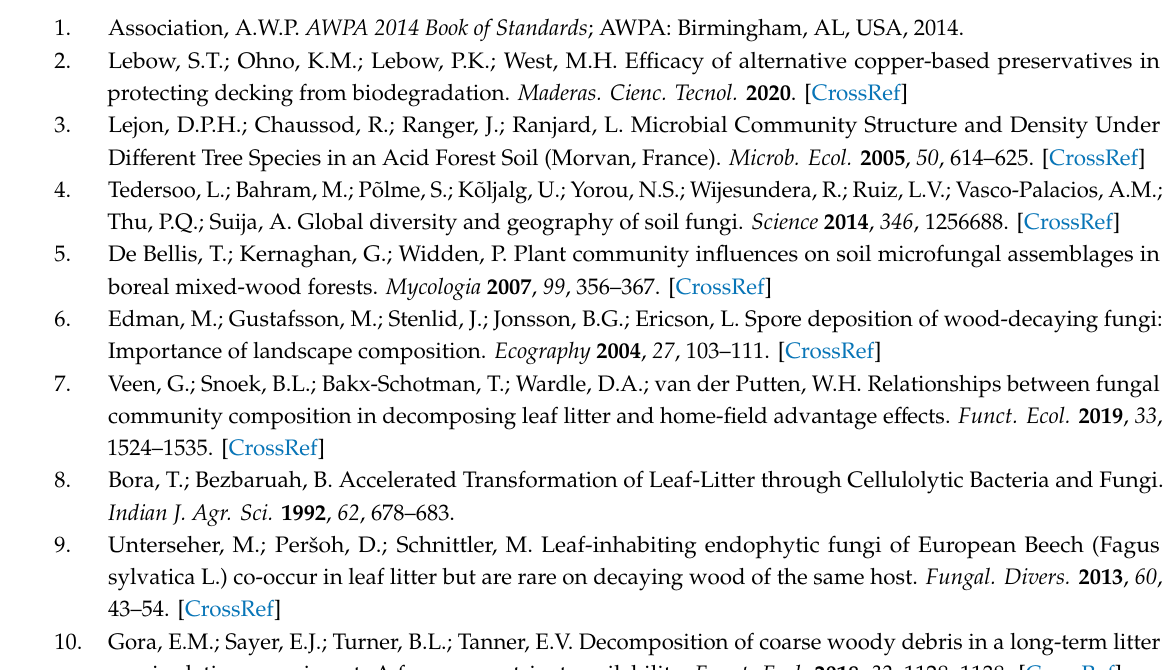
Table S1—Operational Taxonomic Units (OTU) table summarizing counts of OTUs by sample. Table S2—OTU table with assigned guild designations summarizing distribution of guild composition by